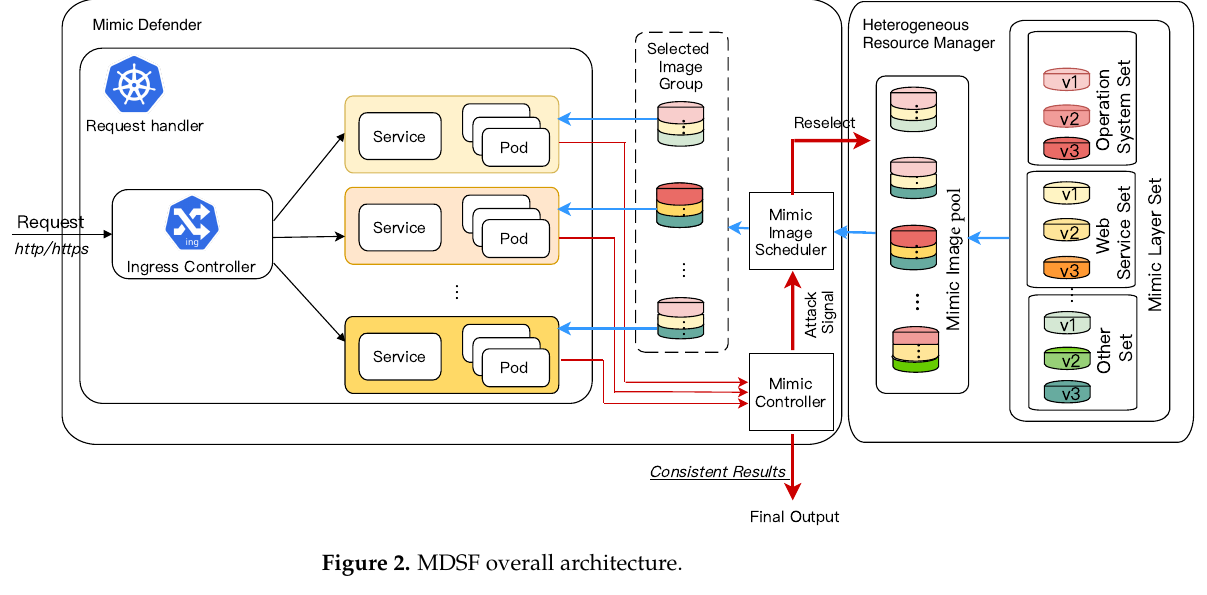
Figure 2. MDSF overall